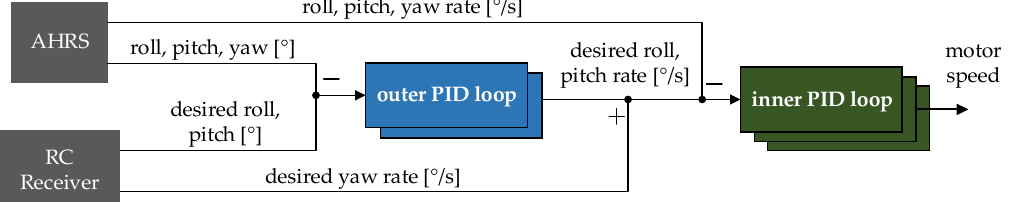
Figure 6. Simplified control loop diagram [5].